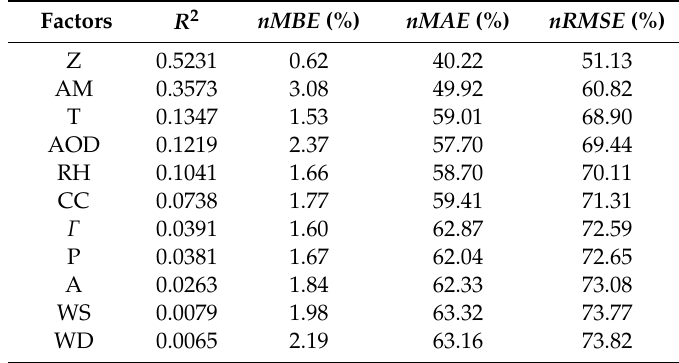
Table 2. Performance of regression model with 1-RM to predict